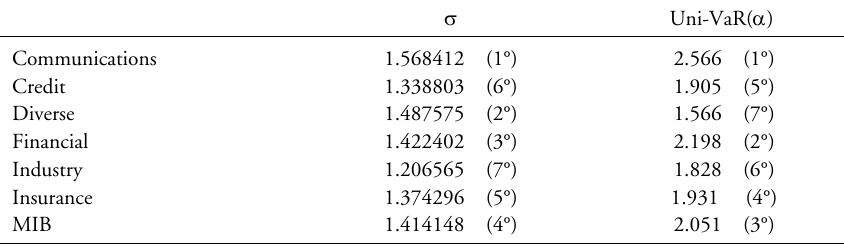
Measures of global risk ( σ and Uni-VaR) and relative rankings within